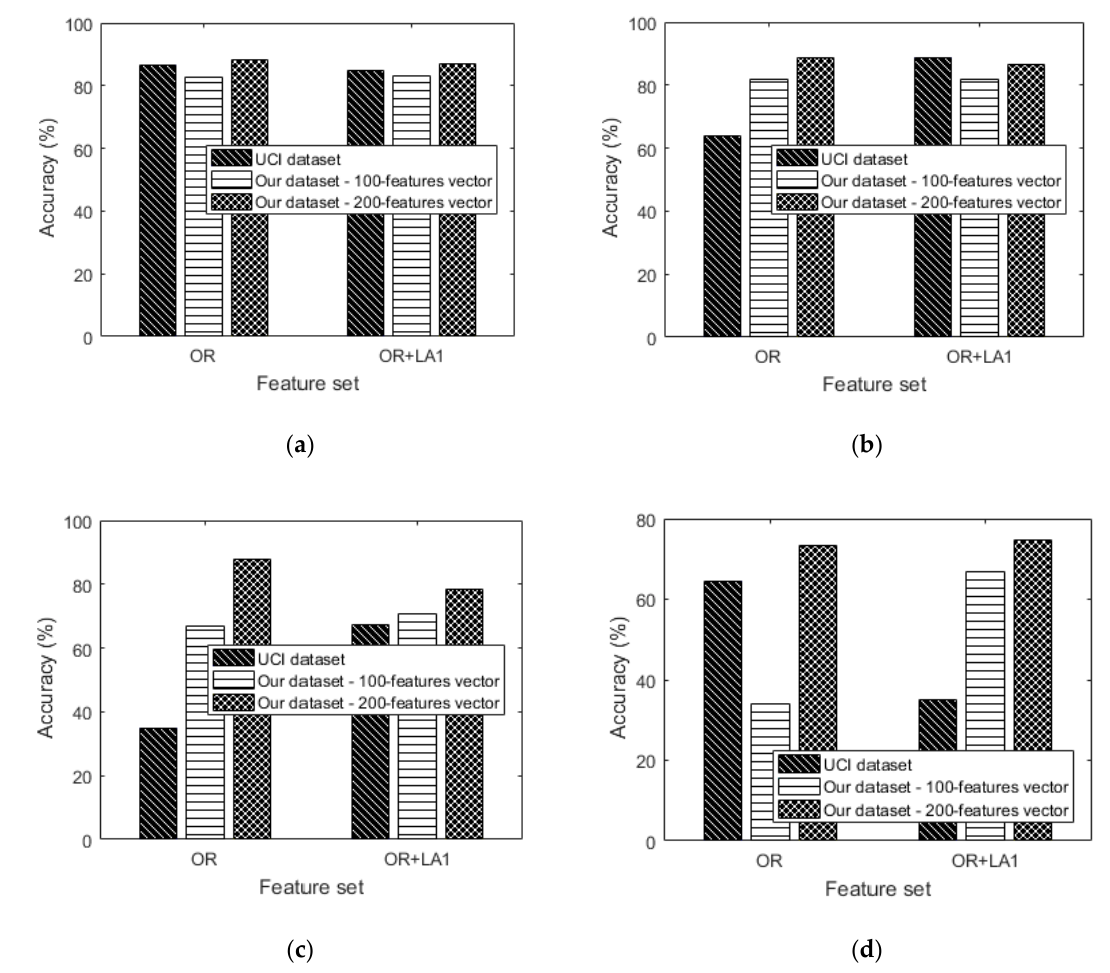
Figure 18. Comparing the performance of OR and OR + LA1 using the UCI dataset and our dataset at various learning rates of: ( a ) 0.0002 ( b ) 0.003 ( c ) 0.006 and ( d ) 0.01.